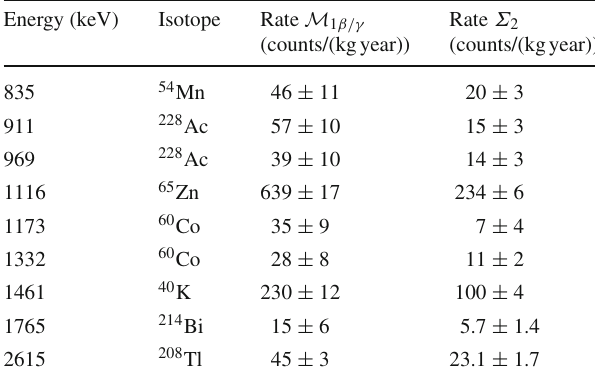
Table 2 γ -Lines identified in the CUPID-0 data and their counting rate in M 1 β/γ and Σ 2 spectra Energy (keV)